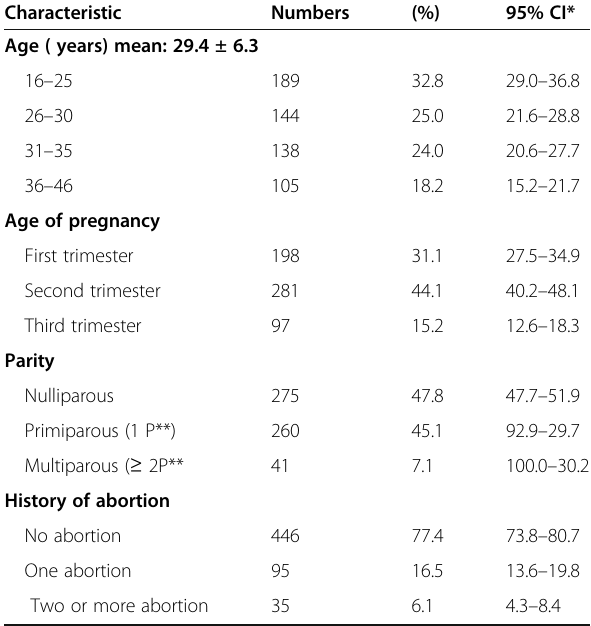
Table 1 Sociodemographic characteristics of pregnant women Characteristic